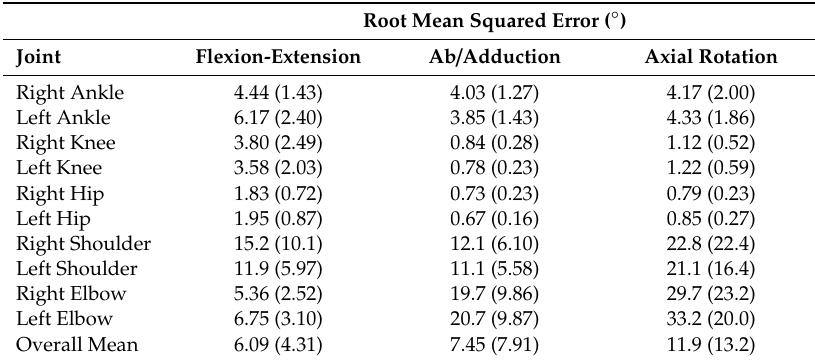
Table 6. Mean RMSE values X IMU vs. V IMU-CAL